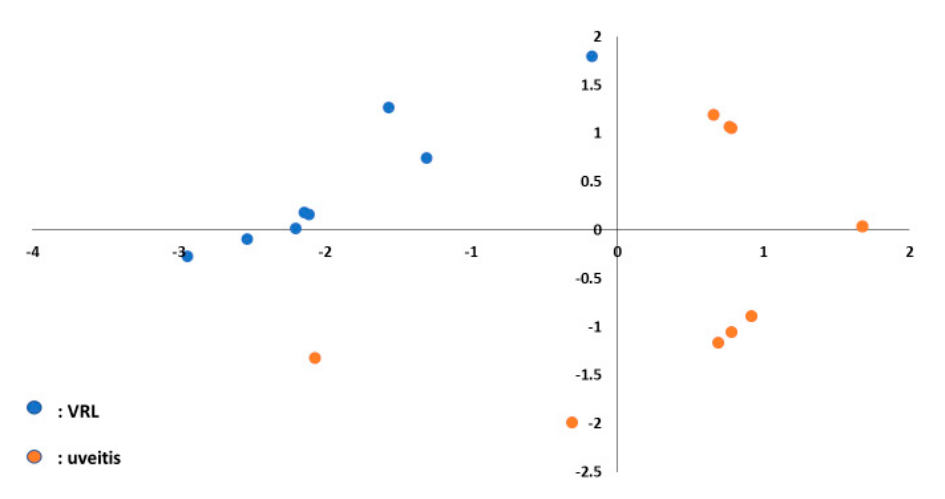
Figure 6. Principal component analysis plot to separate VRL and uveitis using three upregulated miRNAs (miR-6513-3p, 138-2-3p and 4445-3p) in the vitreous. Blue dots indicate VRL and orange dots indicate uveitis with vitreous opacity.